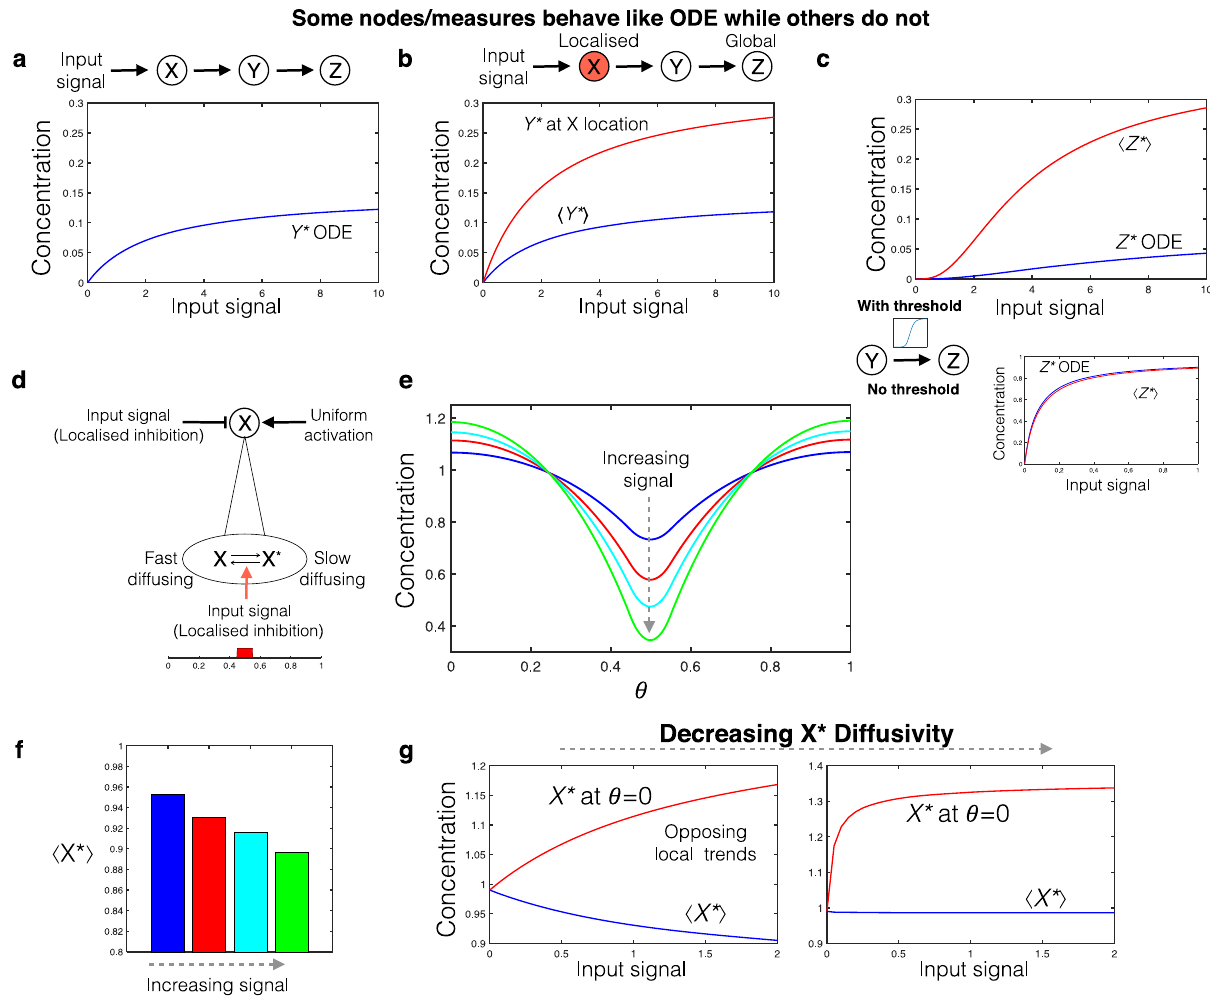
Fig. 6 Measurements and spatial organisation. a Simple signal transduction cascade, no localisation: dose response of node Y (identical to ODE model). b Localising the input node X ( fi xed total amount): while node Y exhibits gradients, its spatial average may still exhibit a quantitatively similar dose response to the ODE model seen in ( a ). However, there is a signi fi cant difference between local (at location where X is localised, red curve) and spatial averaged measures of output (blue curve). c In this case (spatial average measurement), if the regulation of node Z by Y involves no threshold behaviour, the dose response of node Z (spatial average) may be similar, even quantitatively, to the ODE model. If it does involve a threshold, even the spatial average dose response (red curve) can be qualitatively different to the ODE model (blue curve). d Schematic of a node with slow diffusing active form and fast diffusing inactive form. Input signal consists of a localised inhibition at the centre of the domain. e Contrasting responses to input within and away from the input location: decreasing at the input location (consistent with increasing inhibition) and increasing away from this location. f The domain average response exhibits a (decreasing) trend consistent with increasing inhibition. g Contrasting dose response in terms of local concentration of X * (red curve) and global average of X * (blue curve). For even lower diffusivity of X * , the change in average response to increasing signal becomes negligible, while the local level of X * exhibits a prominent ‘ inverse ’